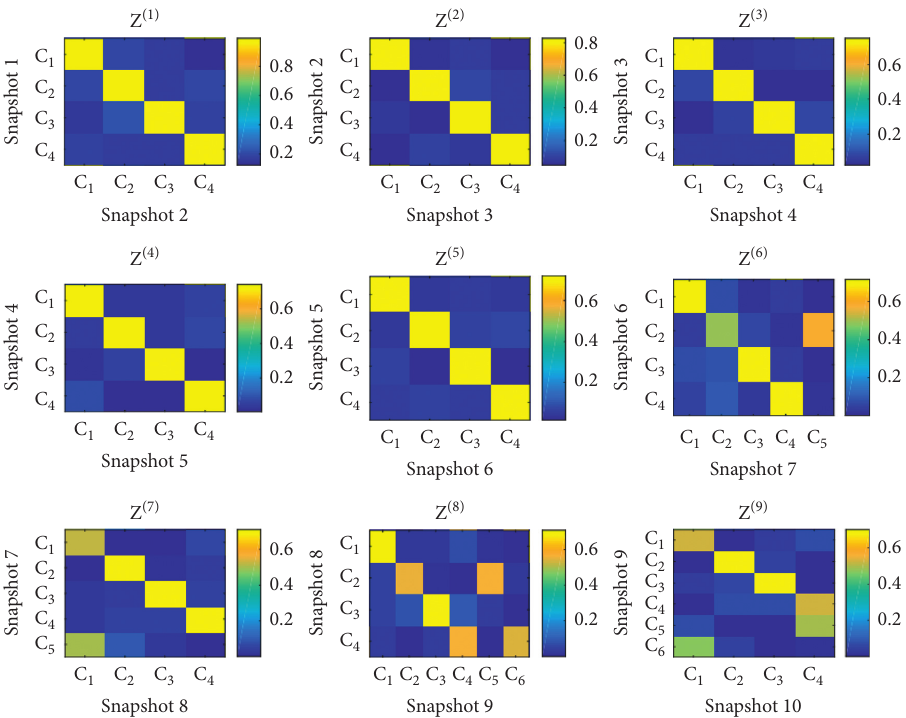
Figure 3: The propensity of the evolution ( Z ( t ) ) between adjacent snapshots on Net. 1.